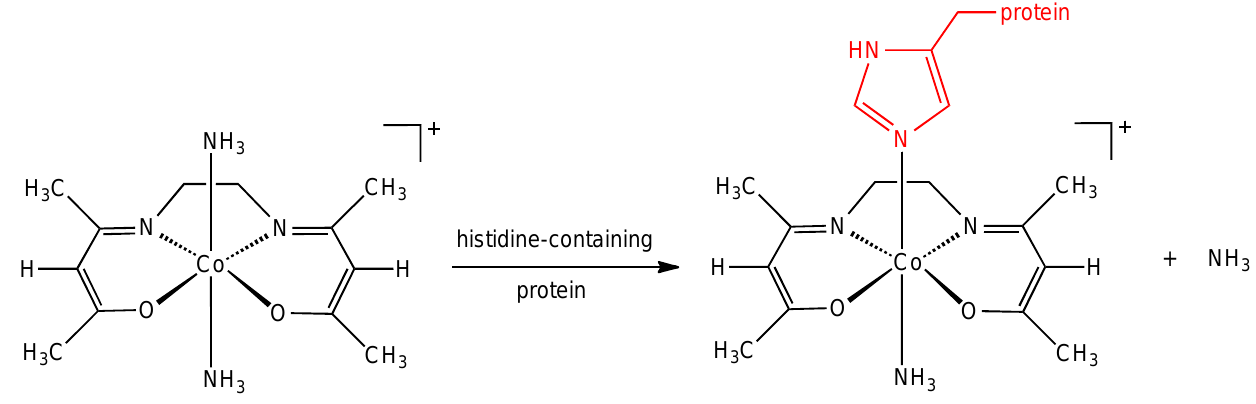
Figure 2. Proposed interaction of histidine containing protein with